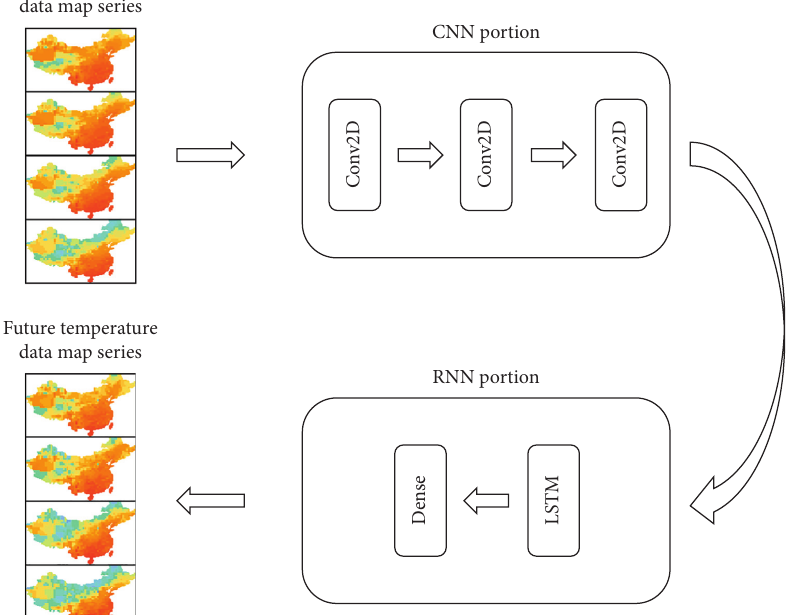
Figure 3: Illustration of CRNN